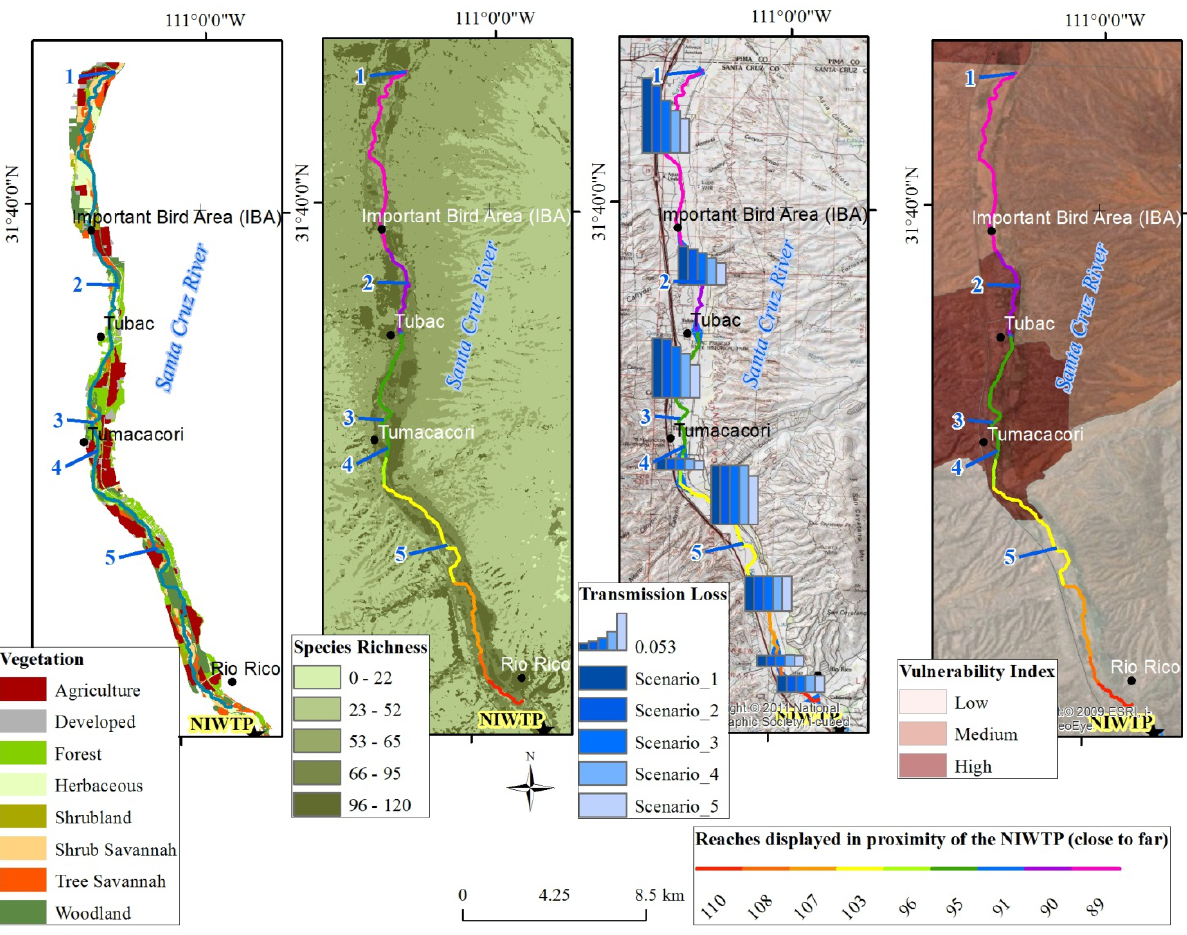
Figure 8. Map series portraying the comparison of various effluent-discharge scenarios of the SCWEPM, where the perennial flow extent for each scenario is numbered (1, 2, 3, 4 and 5). Maps display from left to right: vegetation, habitat species richness, transmission loss (at each reach) and U.S. Census Block groups mapped according to the Modified Socio-Environmental Vulnerability Index